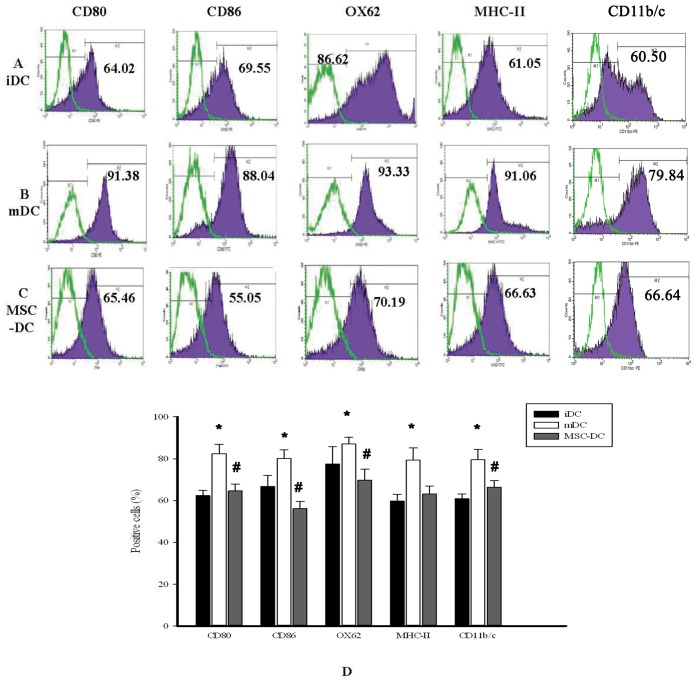
Phenotype analysis of different DCs.(A) FACS histograms showed the expression of cell surface markers on iDCs, which expressed low levels of CD80, MHCII, OX62, CD86 and CD11b/c. OX62 expressed much higher than other makers, because OX62 is an important marker of rat DCs. (B) LPS- stimulated mature DCs (mDCs) showed about equally up-regulated levels of all markers. Except CD86, three makers showed above 90 percent expression. (C) MSC-DC-LPS-activated DCs in co-culture expressed lower levels of the four markers compared with mDCs, but the expression was slightly higher when compared with iDCs. This result suggests that MSCs inhibit DCs phenotype expression (MSC:DC = 1∶10). Data represent mean fluorescence intensity for the surface density of markers. (D) Quantification by image analysis of the positive cells. The numbers in the histograms indicate the mean fluorescence of each DCs markers. *P<0.05(mDC group versus iDC group), #P<0.05(MSC-DC group versus mDC group).